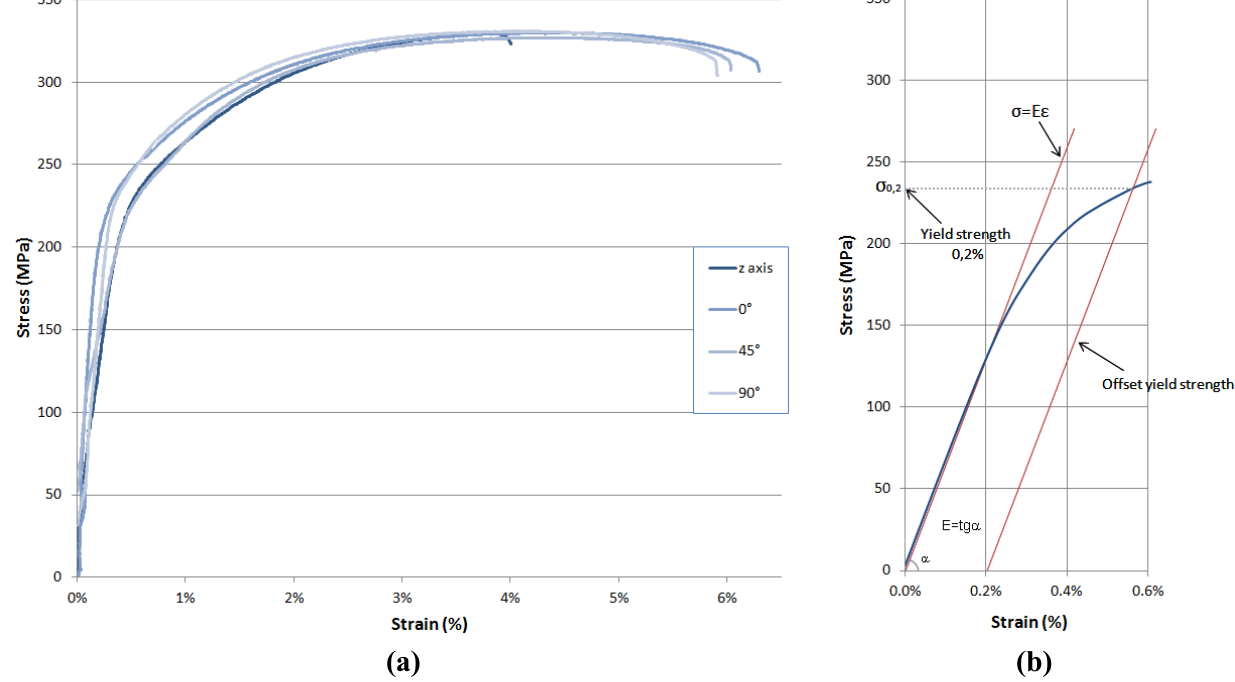
Figure 5. ( a ) Typical stress-strain curves for aluminum alloy DMLS specimens built along four different orientations; ( b ) yield strength and Young’s modulus evaluation for the representative curve of a specimen along z